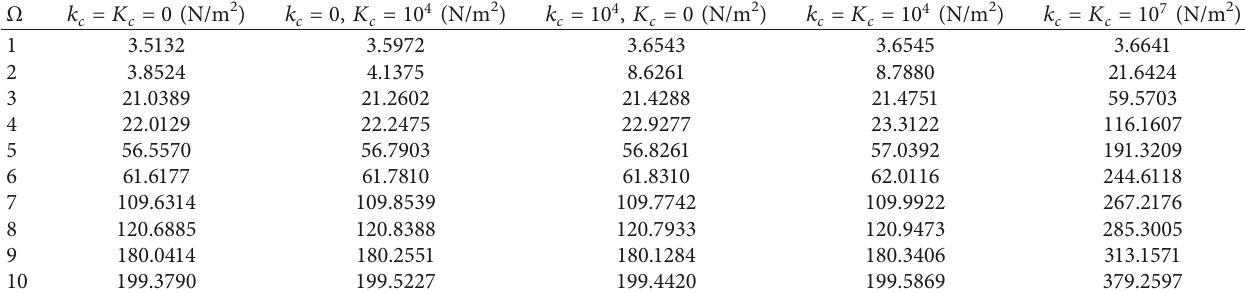
Table 5: Nondimensional natural frequencies for the nonuniform double-beam system under different coupling spring stiffness with c and n 2 of beam 2. (cid:31)